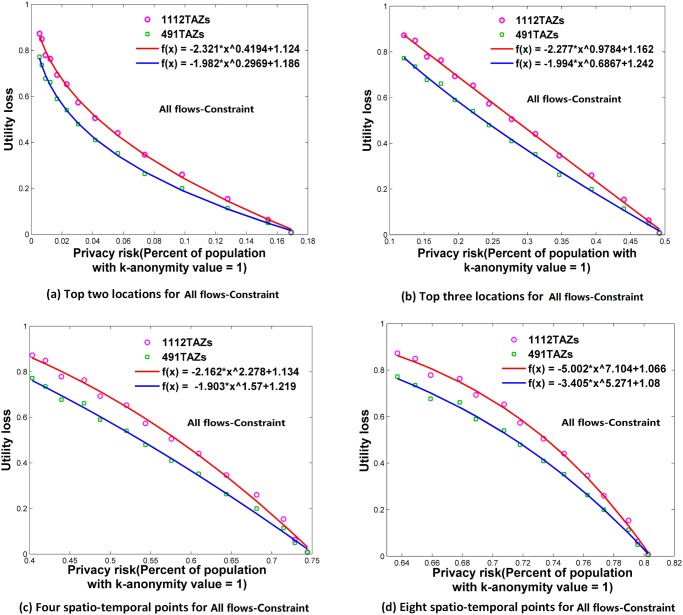
Relationships between privacy risk and data utility using All flows-Constraint.(a) Top two locations. (b) Top three locations. (c) Four spatio-temporal points. (d) Eight spatio-temporal points.